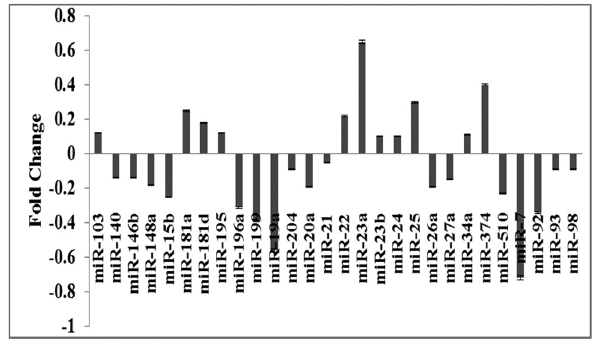
Figure 5: E ff ects of AA treatment on miRNA expression in MCF - 7 cell lines. Microarray pro fi le of miRNA expression in MCF - 7 cells treated with AA for 48 h. The relative increase or decrease in the 29 miRNAs that showed a signi fi cant change in levels of expression after AA treatment compared with untreated cells.